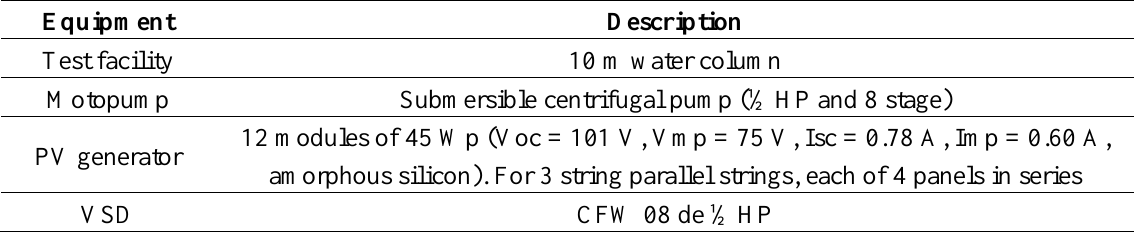
Table 2. Description of test